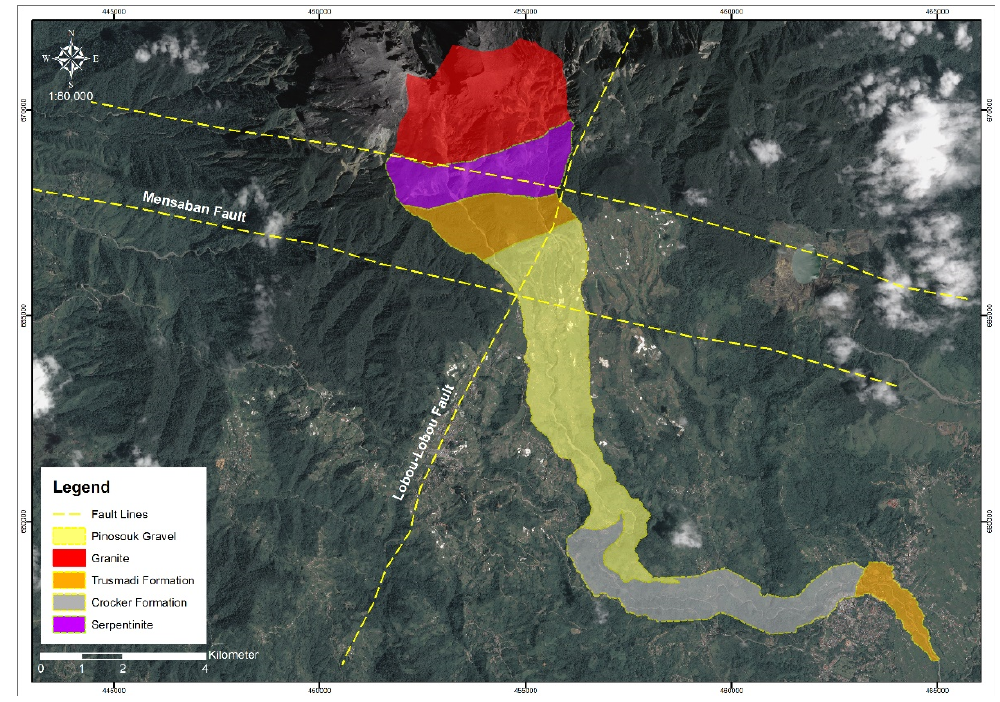
Figure 5. Illustration of the five lithologies within the watershed area synthesised from [8,49–53,55,57] .